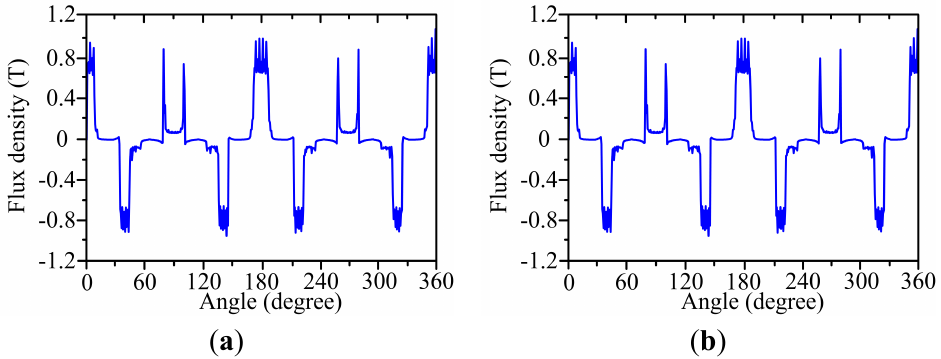
Figure 7. Air-gap flux density waveforms: ( a ) Air-gap 1; and ( b ) Air-gap